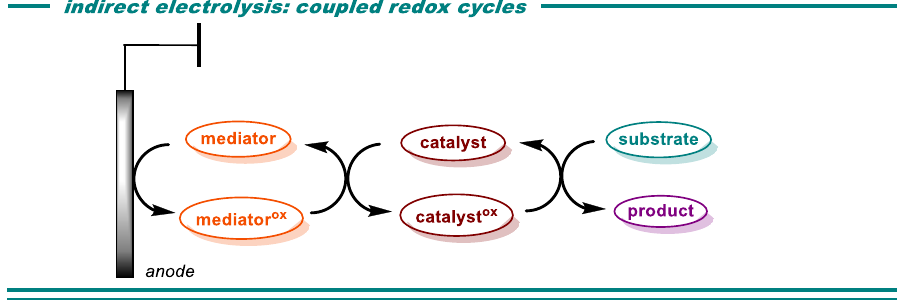
Figure 3. Principle for indirect oxidative electrolysis using coupled redox cycles.